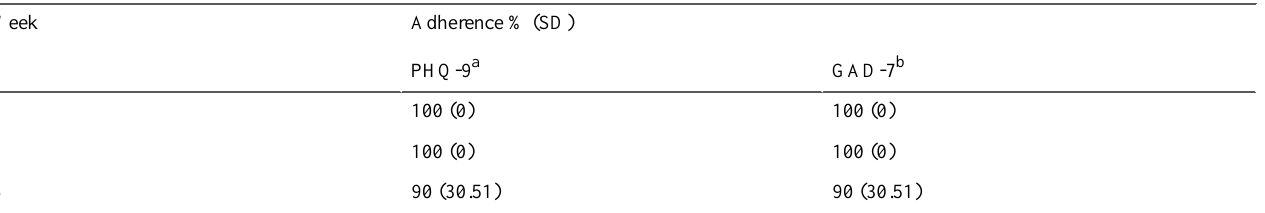
Table 3. Biweekly adherence rates for in-app PHQ-9 and GAD-7